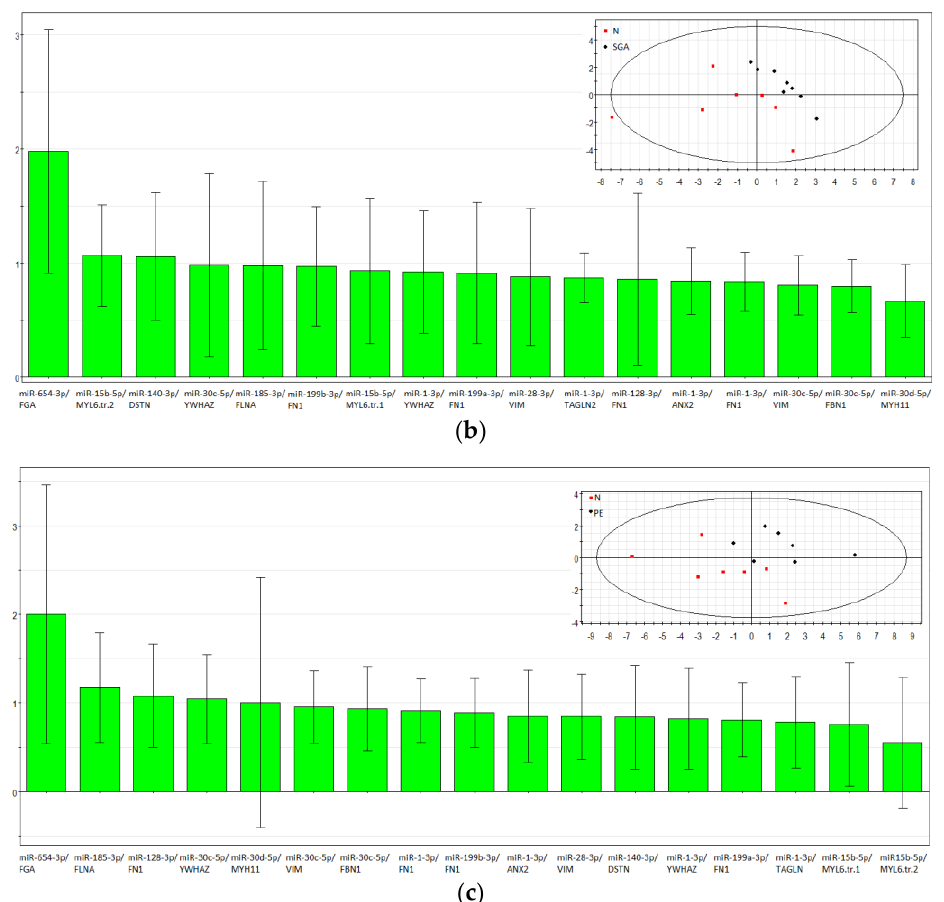
Figure 5. Partial least squares discriminant analysis (PLS-DA). Variable importance in projection (VIP) score plots using (−ΔΔCt) RT-PCR data on the fold change expression level of miRNA relative to its target gene in a sample from the IUGR > 34 and N > 34 groups ( a ), the SGA > 34 and N > 34 groups ( b ), and the PE > 34 and N > 34 groups ( c ). Score plots with the imposition of information of the miRNA‒gene target fold change in the expression level on the sample group type are presented as inserts in the upper right corner of ( a – c ).